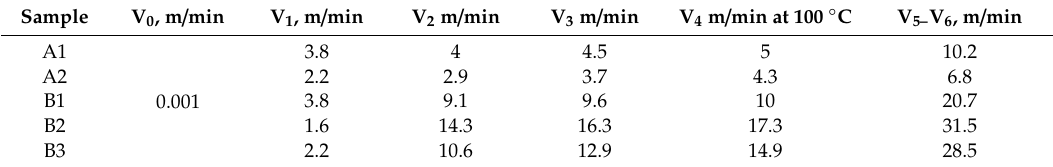
Table 4. Kinematic parameters for the fiber spinning with polyacrylonitrile and its copolymers (PAN).